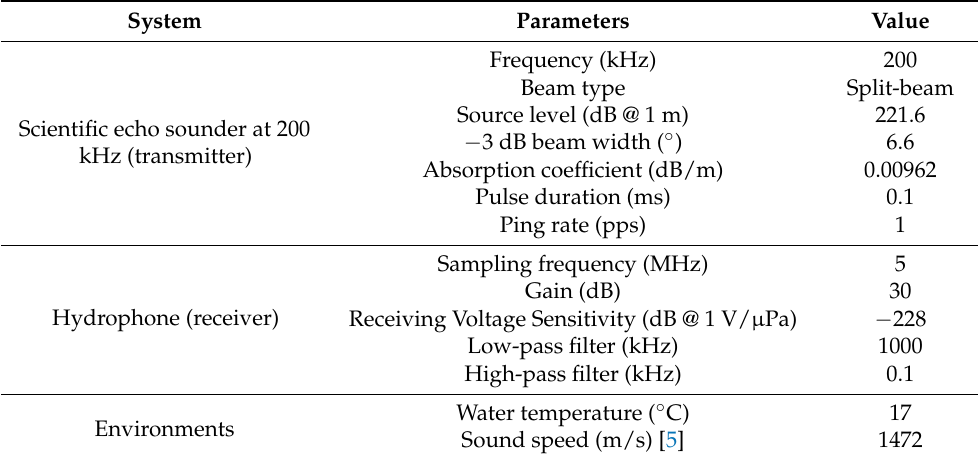
Table 3. Parameters for the attenuation measurements of individual and multiple fishes using the scientific echo sounder and hydrophone.